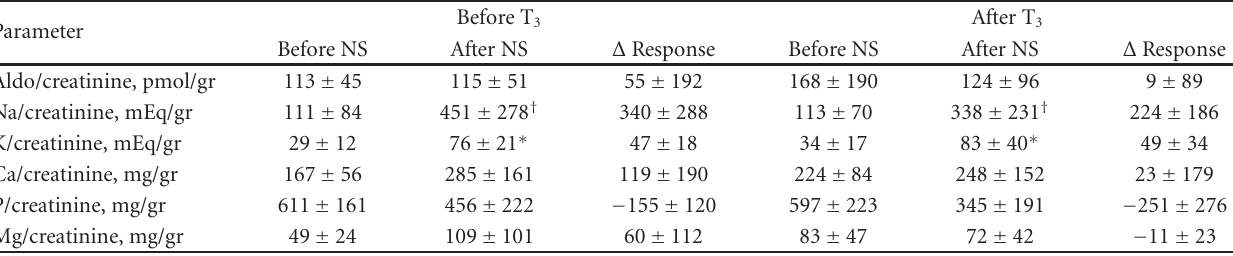
Table 4: Urinary electrolyte excretion before and after normal saline-induced plasma volume expansion at baseline and after T 3 administration.